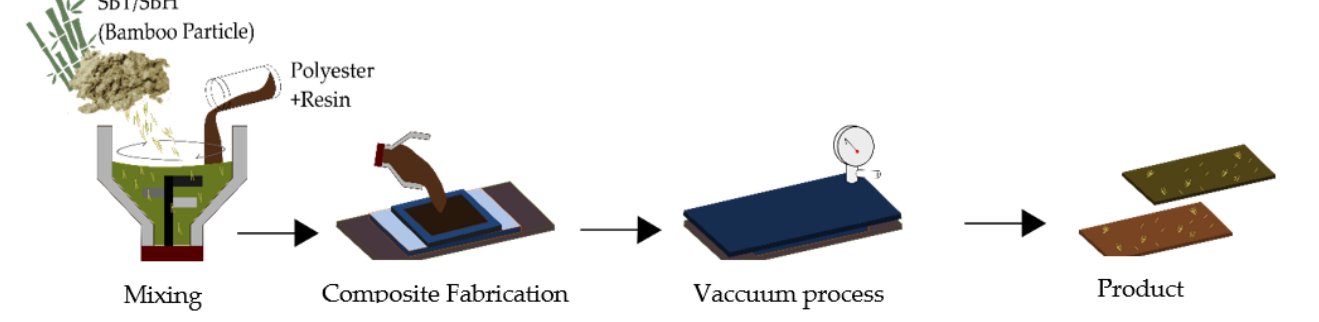
Figure 1. BPRP Composite Fabrication Process.